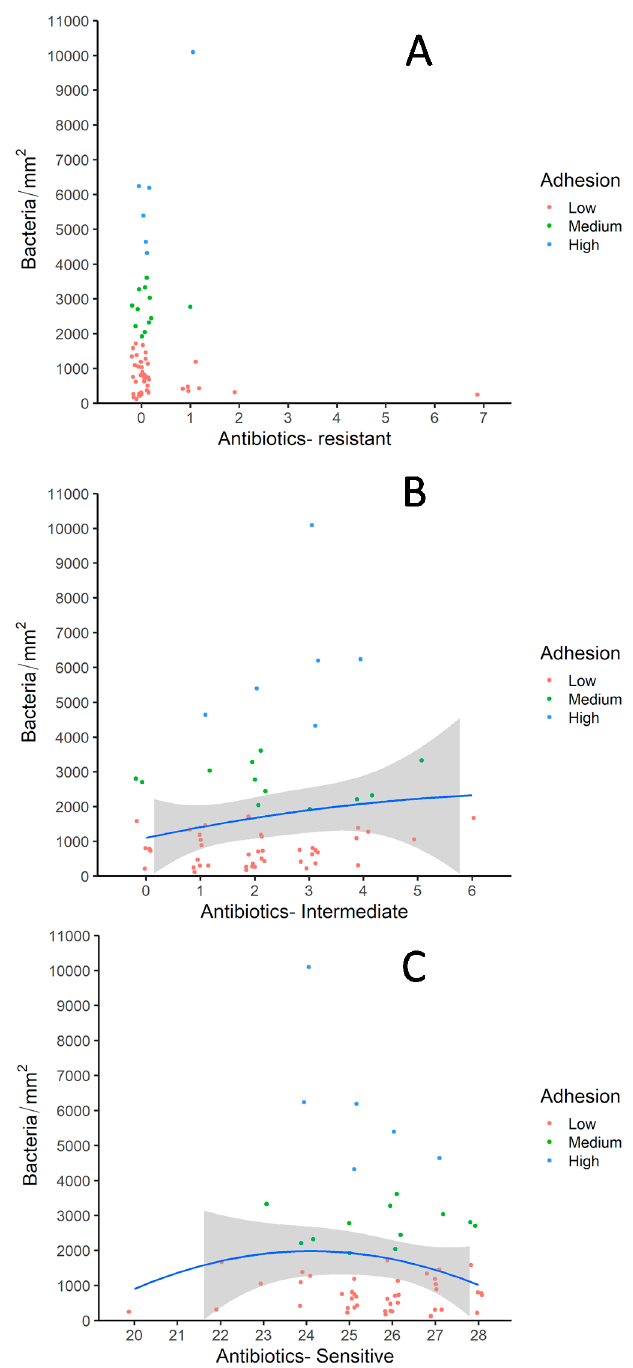
Figure 4. Correlations drawn between antimicrobial susceptibility and adhesion rates of E. coli in cormorant colony ‐ 1. ( A ) Antimicrobial resistance with adhesion rates; ( B ) Intermediary antimicrobial resistance with adhesion rates; ( C ) Antibiotic sensitivity with adhesion rates. Shown are scatterplots with one plot representing one pulsotype.